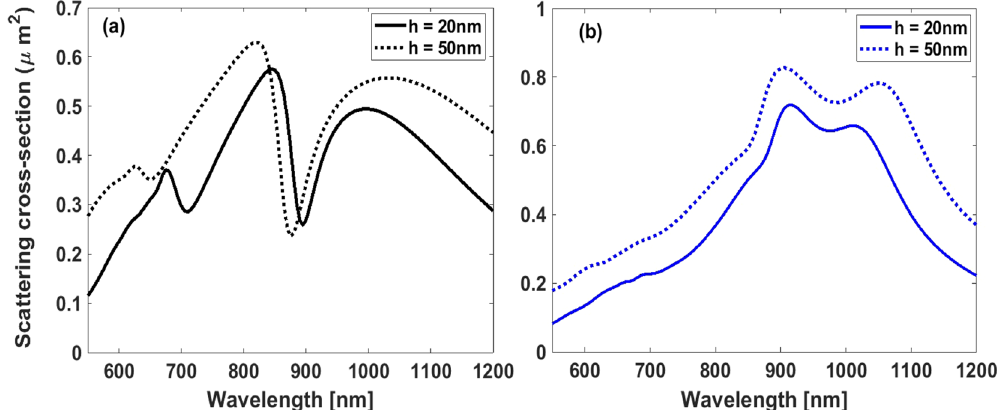
Figure 5. Total SCS of the proposed oligomer for different heights of gold nano-disks ( a ) normal incidence, and ( b ) oblique incidence of angle 60. The remaining parameters are the same as those in